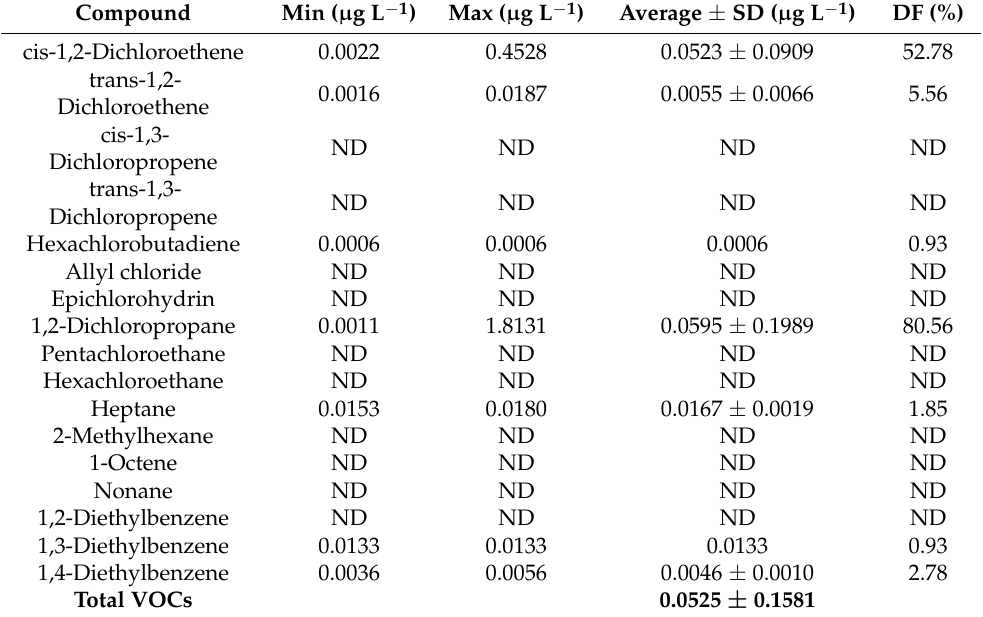
Table 1. Measured VOC concentrations in the sampling period.